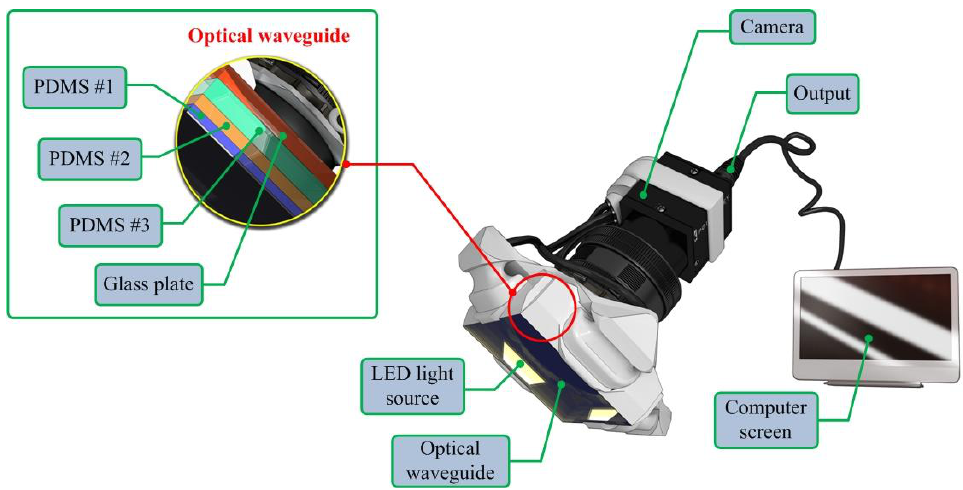
Figure 1. Schematic of the optical-based artificial palpation